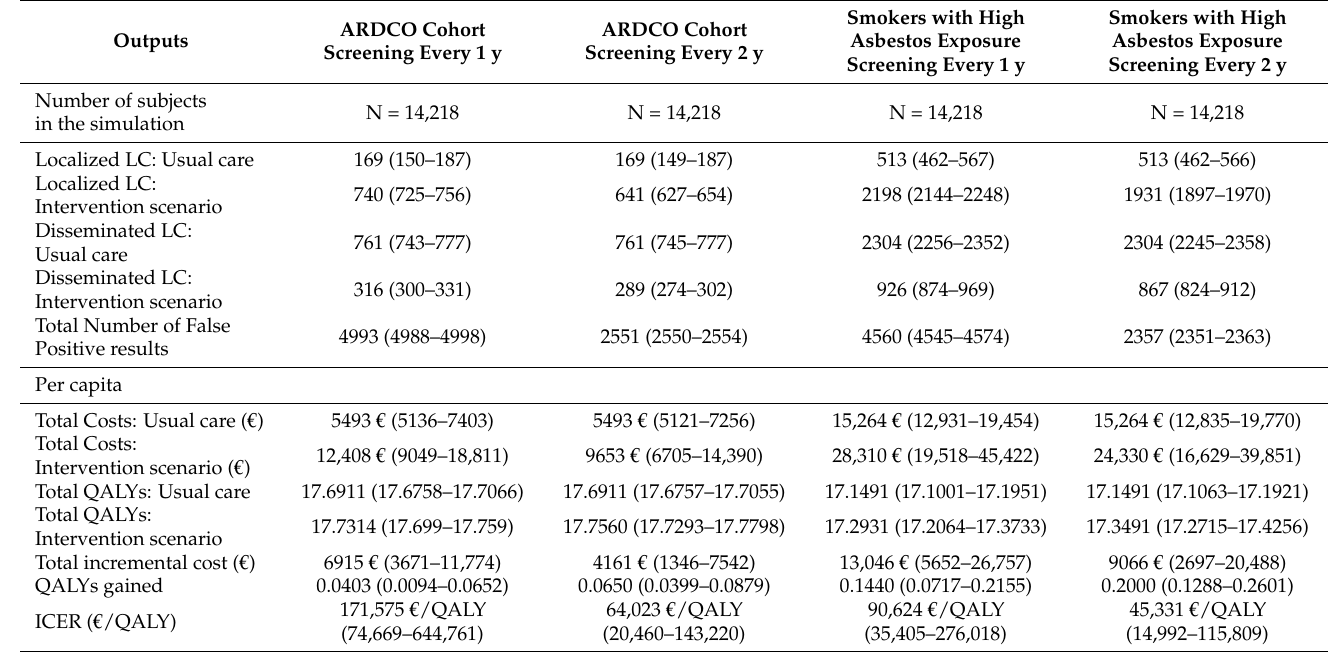
Table 4. Clinical outcomes, health system costs, QALYs gained and ICER for a screening intervention every year or every 2 years, starting at the age of 55, for the 14,218 subjects of ARDCO cohort and for an hypothetical population of 14,218 smokers with high asbestos exposure (time horizon: lifetime, discounted at 3% per annum, uncertainty intervals in parentheses estimated with the minimum and maximum values of the 10,000 Monte Carlo